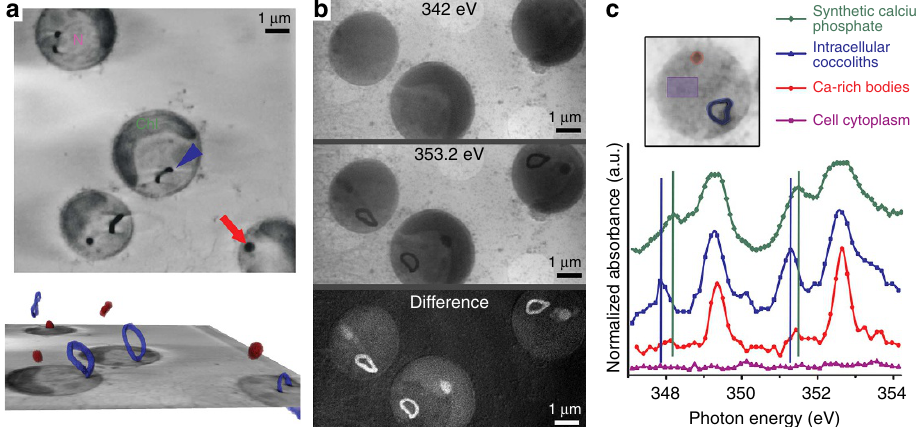
Figure 2 | Cryo-X-ray imaging reveals concentrated calcium pools in E. huxleyi cells. ( a ) Two-dimensional slices from a reconstructed X-ray tomogram with (top) an immature coccolith marked by the arrowhead and a calcium-rich body marked by the arrow, and (bottom) with 3D segmentation of the calcium-rich bodies (red) and intracellular coccoliths (blue). ( b ) X-ray images recorded at an energy below the Ca L 2,3 -egde (342eV), at the edge energy (353.2eV) and the grey value difference between both images. ( c ) Averaged XANES spectra of the Ca L 2,3 -edge. For each spectrum, data from the relevant pixels of four cells were averaged; the inset shows the exact locations in one of these cells. Notice the difference in the position of the crystal field peak (vertical lines) between coccolith calcite and synthetic calcium phosphate. Figure is accompanied by Supplementary Movie